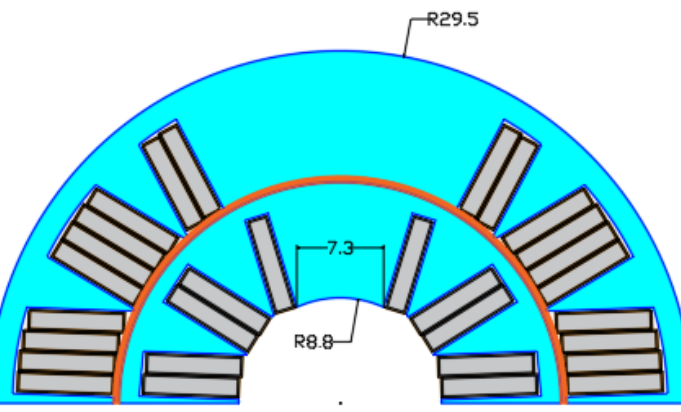
Figure 4. Cross ‐ section of the coil inside the support structure. Figure 4. Cross-section of the coil inside the support structure.